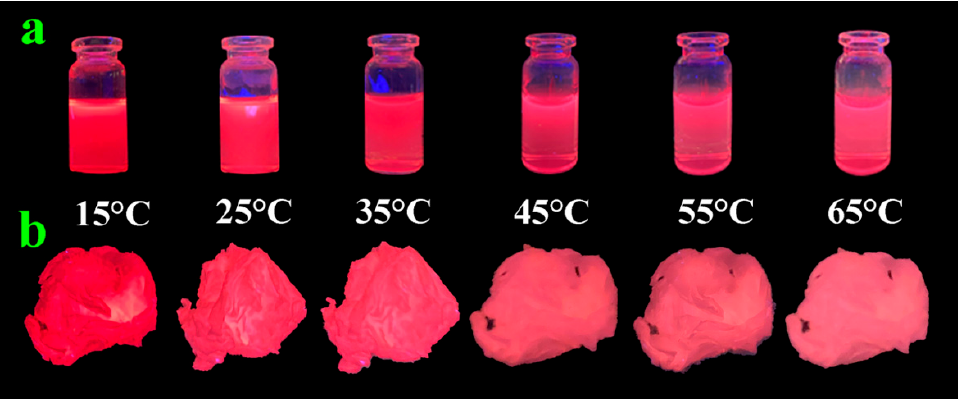
Figure 5. ( a , b ) Fluorescence change in AuNC solution and AuNCs@PAM NFs under UV lamp illu- mination at 15 °C–65 °C. illumination at 15 ◦ C–65 ◦